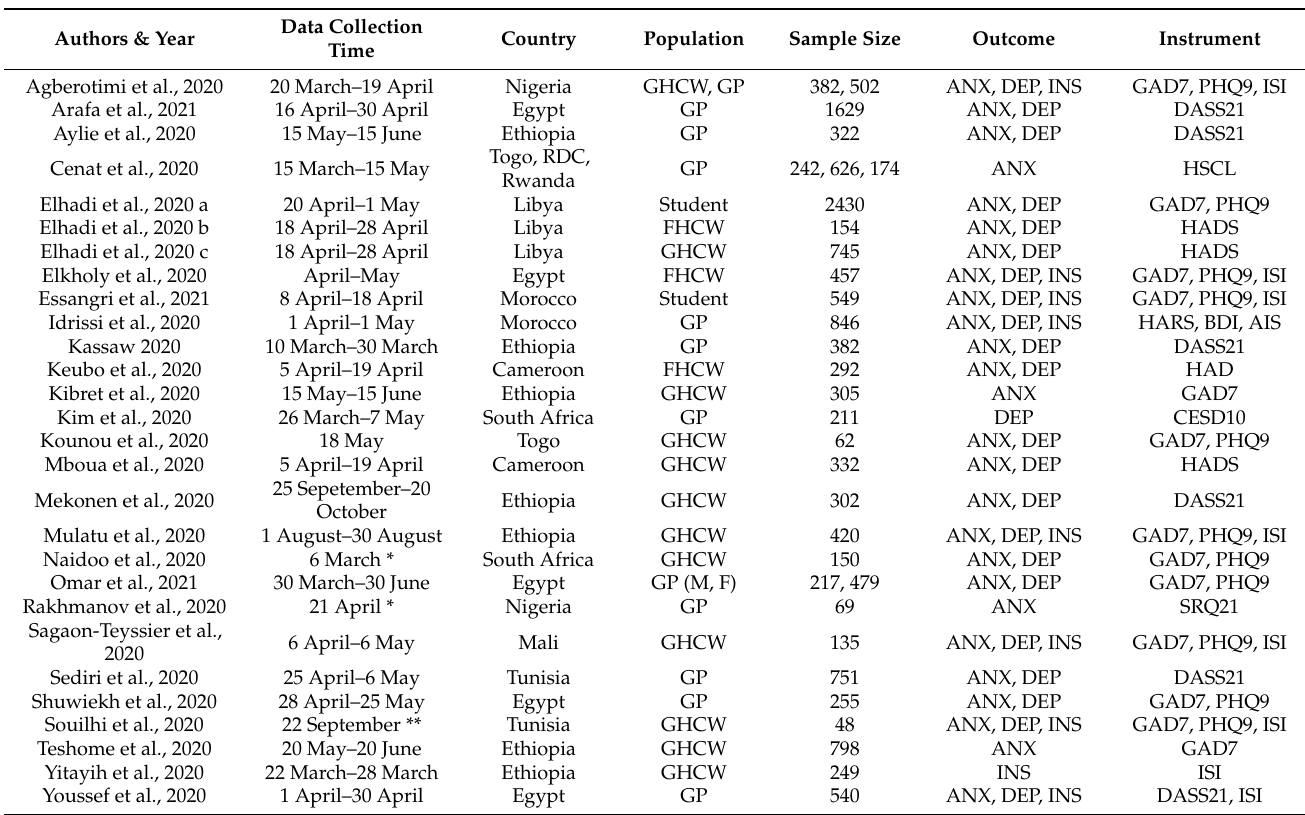
Table A3. Studies included in this